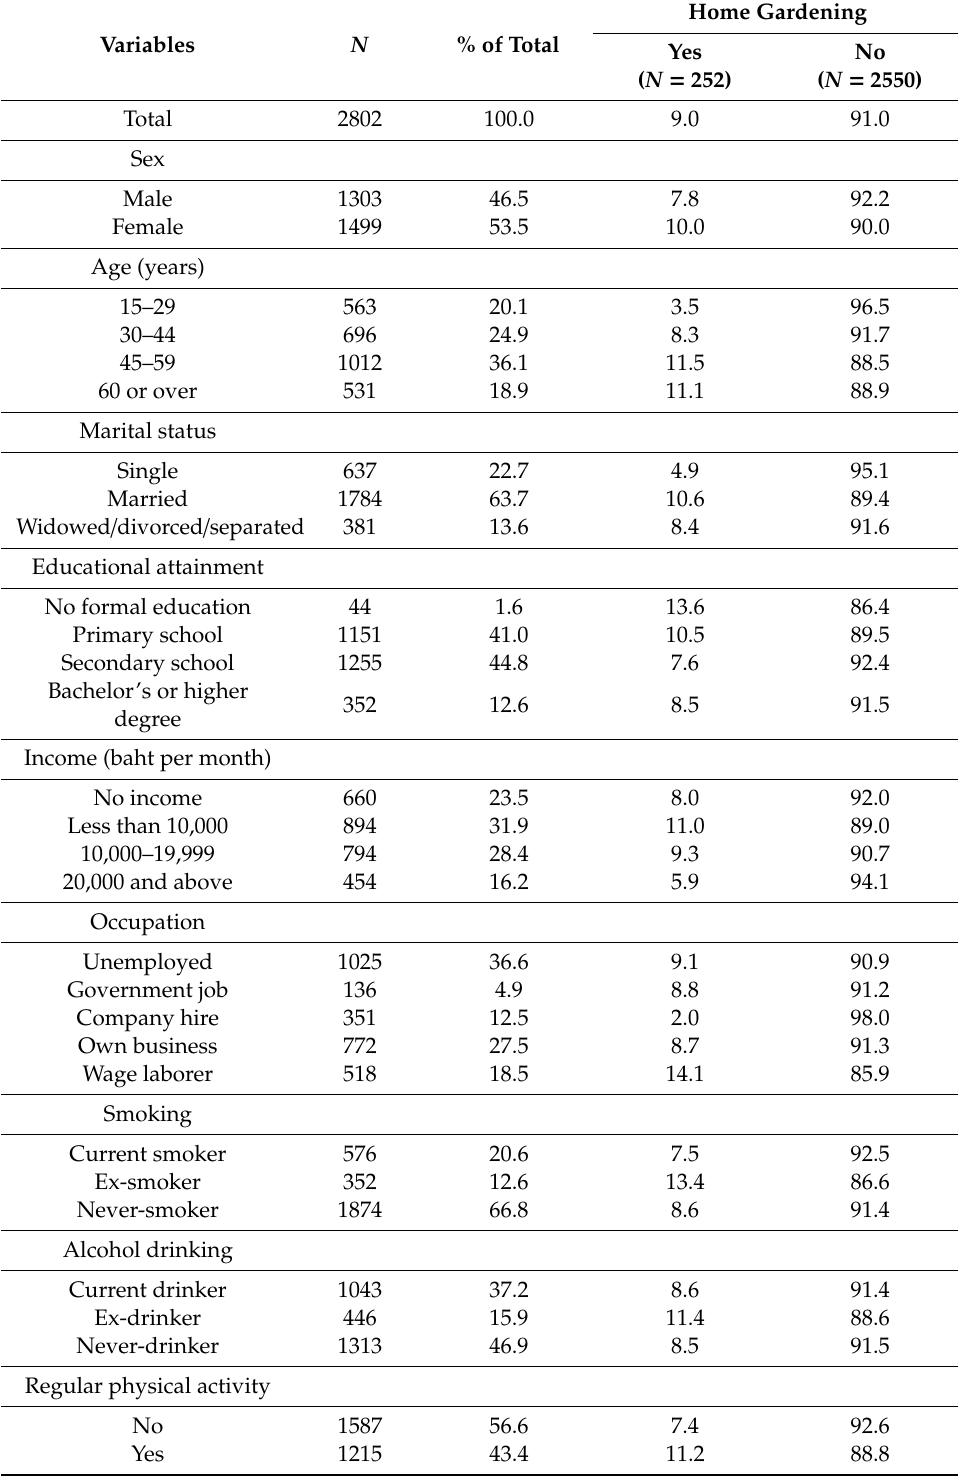
Table 3. Socio-demographic characteristics, health-related behaviors, and practicing home gardening of urban non-farming residents ( N =